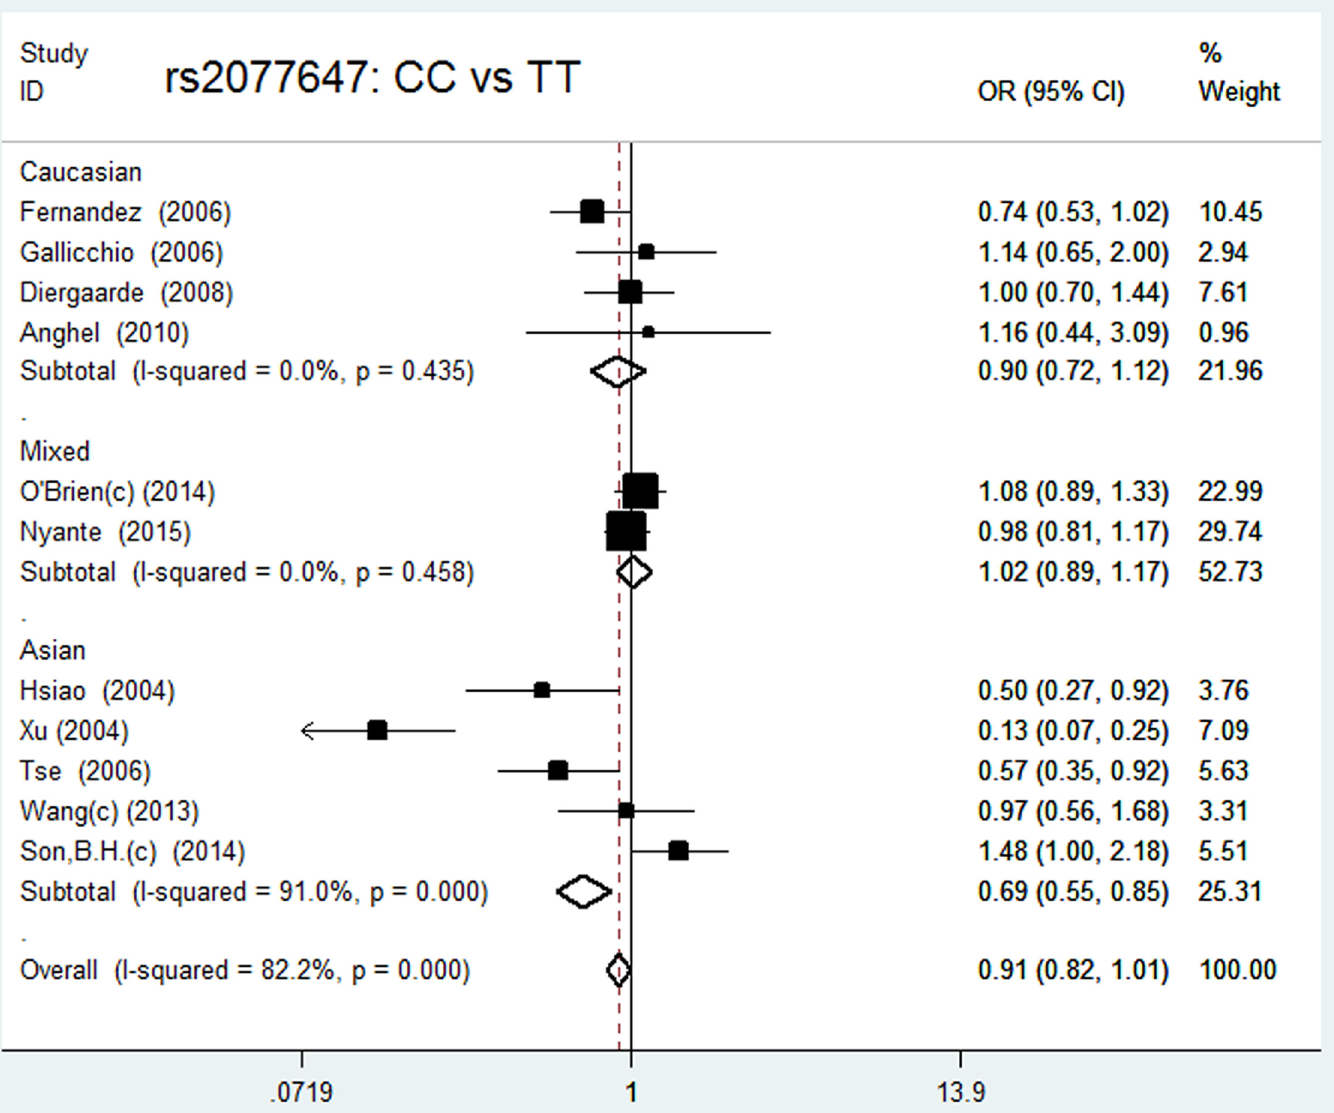
Fig 3. Forest plot of the association between rs2077647 and breast cancer risk in different ethnicities in the variant homozygote versus wild-type homozygote model.